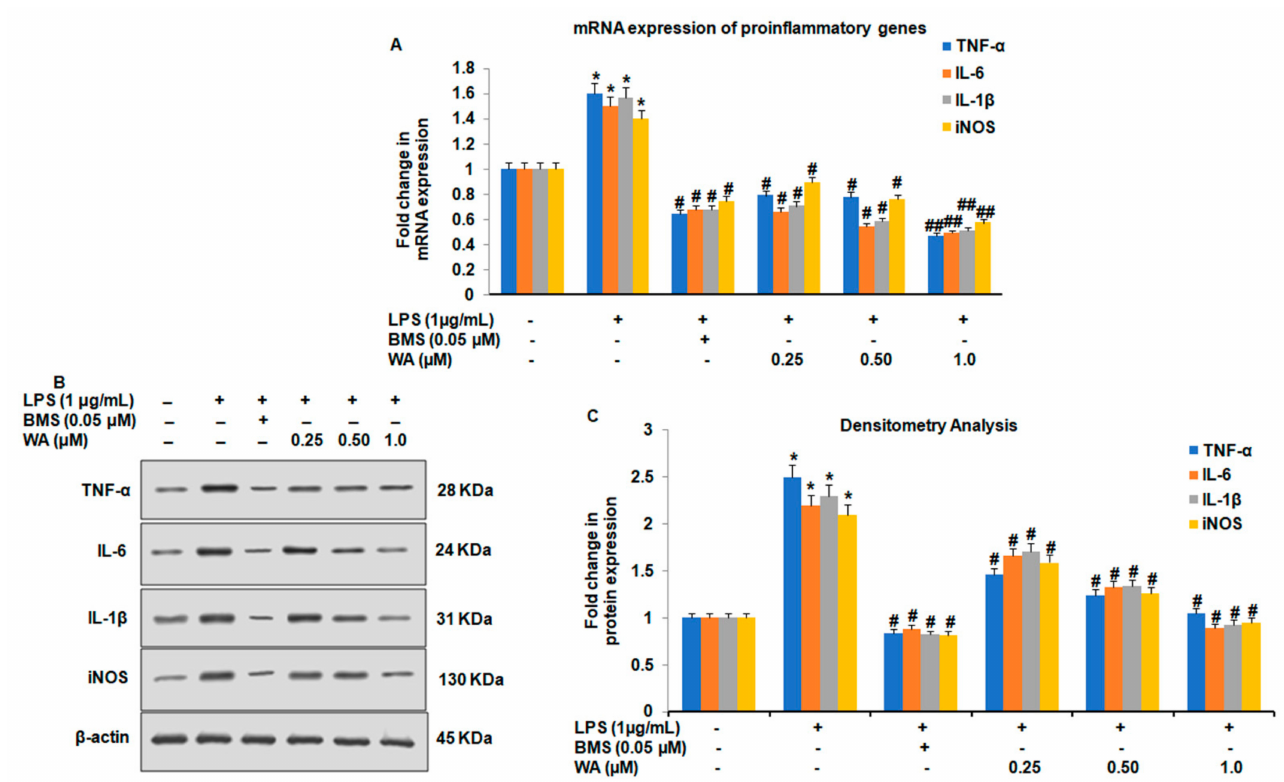
Figure 4. Effect of WA on the expression of pro-inflammatory cytokines after LPS stimulation in peritoneal macrophages. ( A ) The histogram represents the mRNA expression by RT-quantitative PCR of proinflammatory cytokines TNF- α , IL-6, IL-1 β , and iNOS of LPS (1 µ g/mL)-stimulated peritoneal macrophages exposed to varying doses of WA, along with the BMS (0.05 µ M), LPS-stimulated, and untreated control groups, after 48 h. ( B ) Protein expression as determined by immunoblotting of pro-inflammatory cytokines TNF- α , IL-6, IL-1 β , and iNOS of LPS (1 µ g/mL)-stimulated peritoneal macrophages exposed to varying doses of WA, along with the BMS (0.05 µ M), LPS-stimulated, and untreated control groups, after 48 h. ( C ) The histogram represents the fold changes in protein expression as determined by densitometry of pro-inflammatory cytokines TNF- α , IL-6, IL-1 β , and iNOS of LPS (1 µ g/mL)-stimulated peritoneal macrophages exposed to varying doses of WA, along with BMS (0.05 µ M), LPS-stimulated, and untreated control groups, after 48 h. Experimental data are presented as the mean ± SEM of three independent experiments. * p ≤ 0.05 (comparison vs. LPS only), # p ≤ 0.05, and ## p ≤ 0.01 (comparison vs. +LPS) are statistically